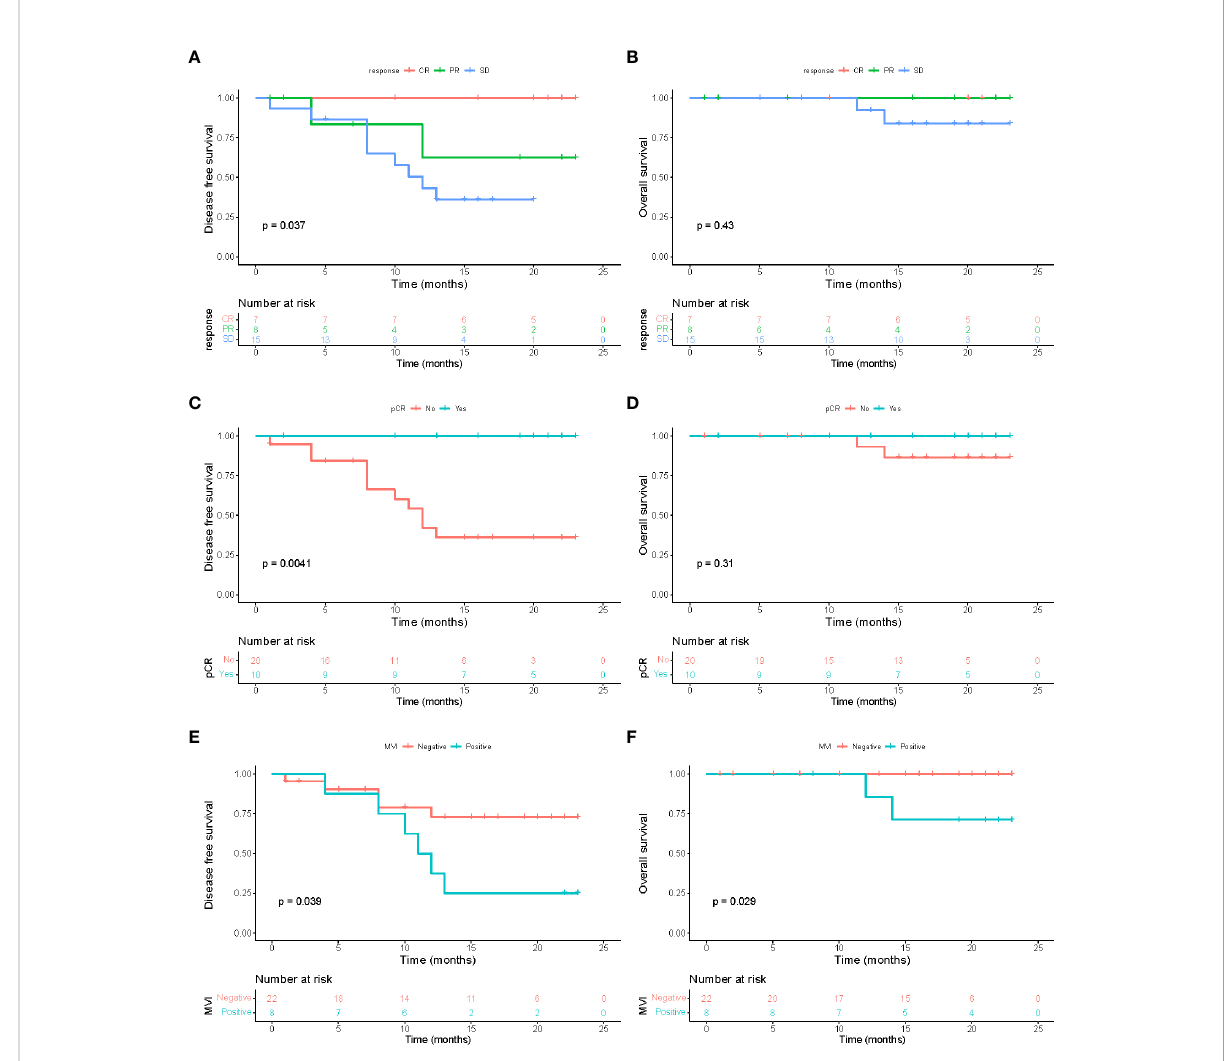
FIGURE 7 Survival analysis. Disease-free survival (A) and overall survival (B) among patients with different treatment response to combinational therapy evaluated via preoperative MR imaging (mRECIST). Disease-free survival (C) and overall survival (D) between patients who did and did not achieve a pathological complete response (pCR) in all resected specimens. Disease-free survival (E) and overall survival (F) between patients with and without microvascular invasion (MVI) in resected tumor